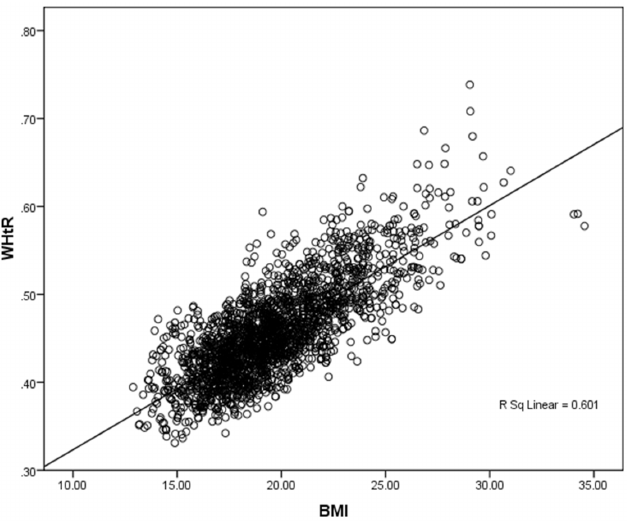
Fig 6. Scatter plot of interaction between BMI and WHtR across the overall study population.